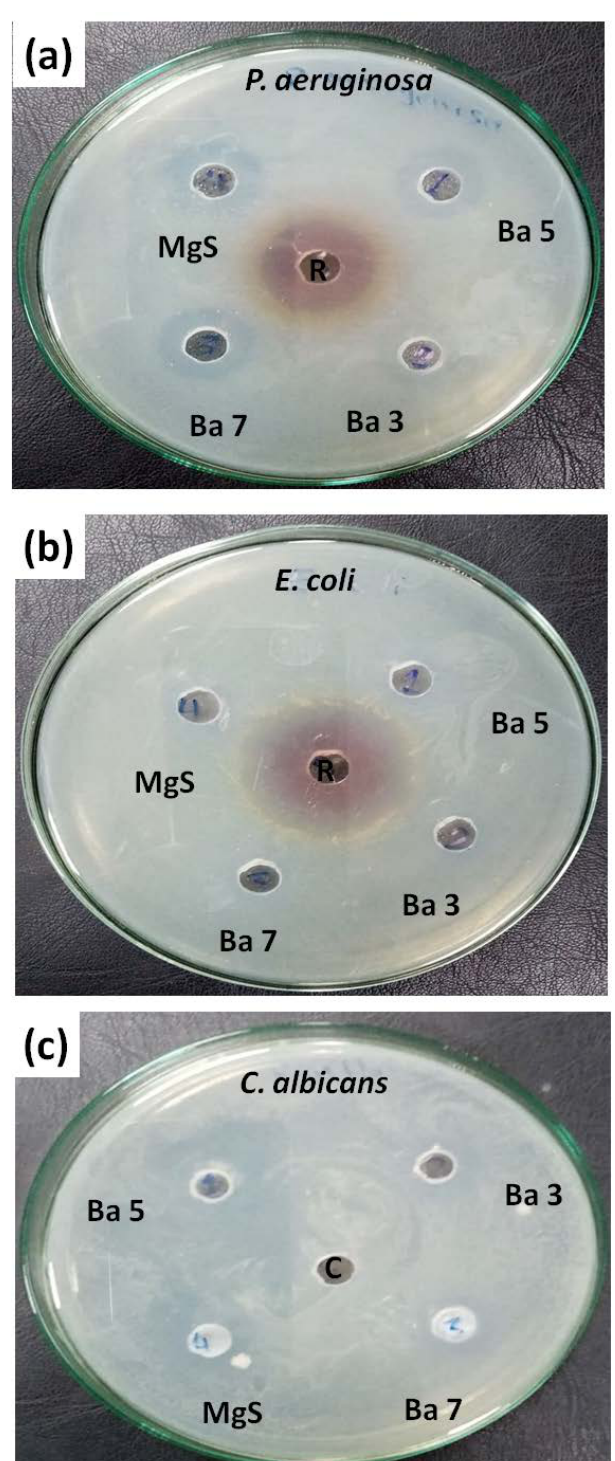
Figure 8. Antibacterial capabilities of MgS before and after doping with BaO against bacterial strains ( a ) Pseudomonas aeruginosa , ( b ) Esherichia coli and ( c ) Candida albicans.